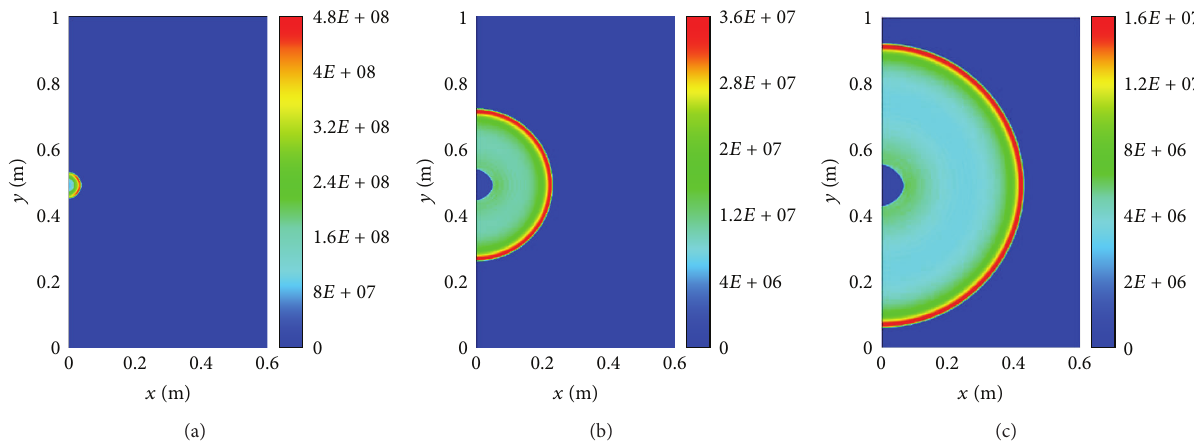
Figure 3: Pressure nephograms after column charge detonation (from left to right the times are (a) 0.01 ms, (b) 0.13 ms, and (c) 0.26 ms).